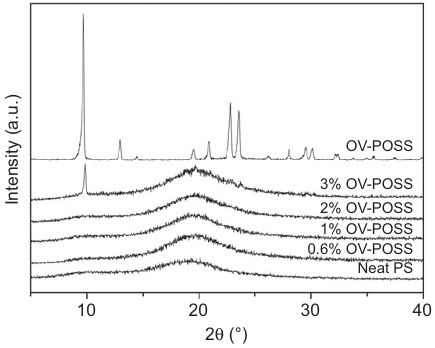
Figure 3 X-ray diffraction patterns of OV-POSS, neat PS, and PS-OV- POSS composites with various OV-POSS contents.